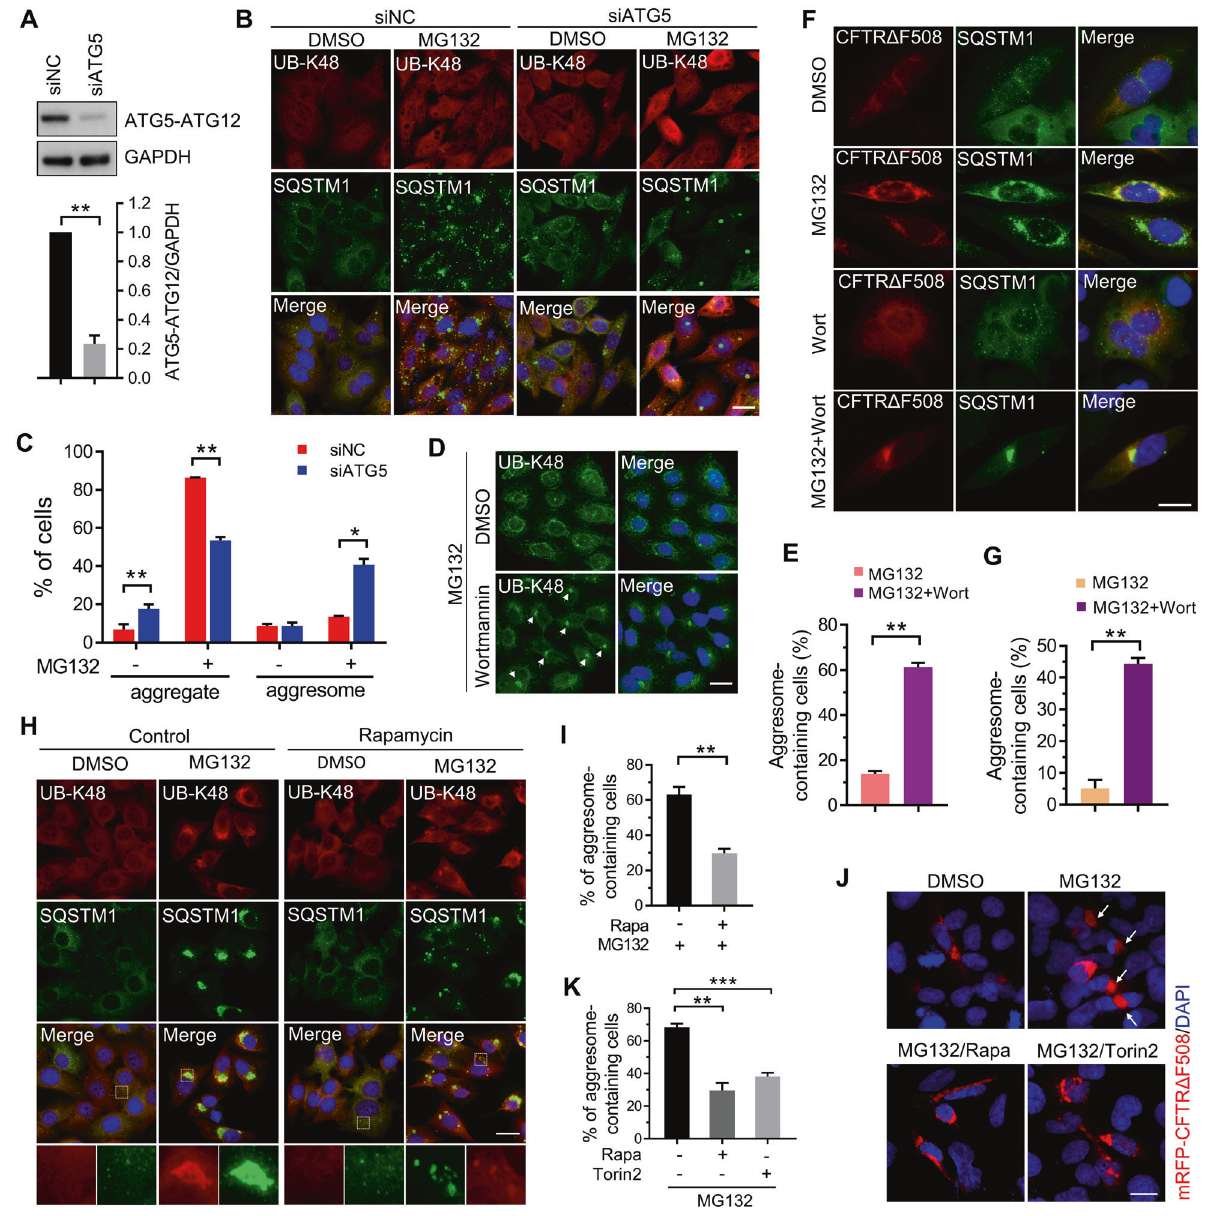
Fig. 3 Blocking autophagy promotes proteasome inhibitor-induced aggresome formation. A HeLa cells were transfected with siRNA targeting ATG5 (siATG5) or control siRNA (siNC) for 48 h. The ef fi ciency of ATG5 knockdown was analyzed with western blot using anti-ATG5 and anti-GAPDH antibodies. Quantitative data are mean ± SEM of three independent experiments. ** P < 0.01. B HeLa cells were transfected with siRNA targeting ATG5 (siATG5) or control siRNA (siNC) for 48 h, and then treated with DMSO or 1 μ M MG132 for 14 h. The aggresome formation was analyzed by immunostaining with anti-UB-K48 (Red) and anti-SQSTM1 (Green) antibodies. Nuclei were stained with DAPI (blue). Scale bar: 20 μ m. C Quantitative analysis of results in ( C ). D HeLa cells were treated with MG132 (1 μ M), or MG132 (1 μ M)/Wortmannin (5 μ M) for 14 h. The aggresome formation was analyzed by immunostaining with anti-UB-K48 (Green). Nuclei are stained with DAPI (blue). Scale bar: 20 μ m. E Quantitative analysis of results in ( E ). F HeLa cells were transfected with plasmids expressing mRFP-CFTR Δ F508 for 24 h, and then treated with DMSO (control), or MG132 (1 μ M), or Wortmannin (5 μ M), or MG132 (1 μ M)/ Wortmannin (5 μ M) for 14 h. The aggresome formation was analyzed by immunostaining with anti-SQSTM1 (Green) antibodies. Nuclei were stained with DAPI (blue). Scale bar: 10 μ m. G Quantitative analysis of results in ( F ). H A375 cells with or without 2 μ M Rapamycin pretreatment for 10 h were treated with DMSO (control) or MG132 (2 μ M) for 14 h. The aggresome formation was analyzed by immunostaining with anti-UB-K48 (red) and anti-SQSTM1 (green) antibodies. Nuclei were stained with DAPI (blue). Scale bar: 20 μ m. I Quantitative analysis of results in ( H ). J AD293 cells were transfected with plasmids expressing mRFP-CFTR Δ F508 for 24 h, and then treated with DMSO (control), or MG132 (2 μ M), or MG132 (2 μ M)/ Torin 2 (1 μ M) for 14 h, or pretreated with Rapamycin (2 μ M) for 10 h and then treated with MG132 (2 μ M)/Rapamycin (2 μ M) for 14 h. The aggresome formation of mRFP- CFTR Δ F508 was analyzed by fl uorescence microscope. Nuclei were stained with DAPI (blue). Scale bar: 20 μ m. K Quantitative analysis of results in ( J ). For C , E , G , I , and K , at least 50 cells were randomly selected from each group to score for aggresomes. Data are mean ± SEM of three independent experiments. * P < 0.05, ** P < 0.01, *** P < 0.001.